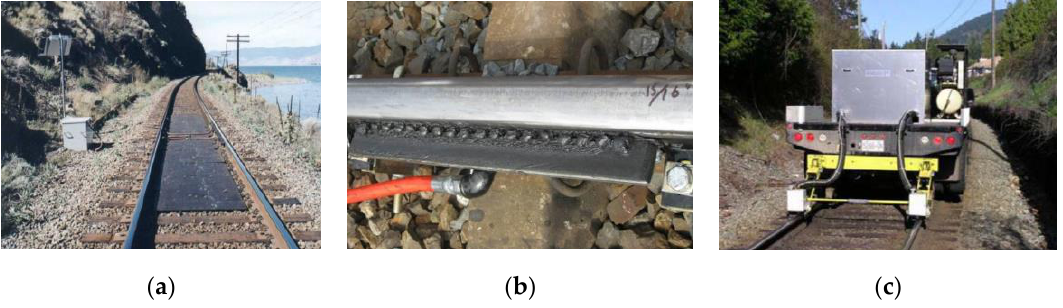
Figure 6. Example of rail based and vehicle based lubrication [20].